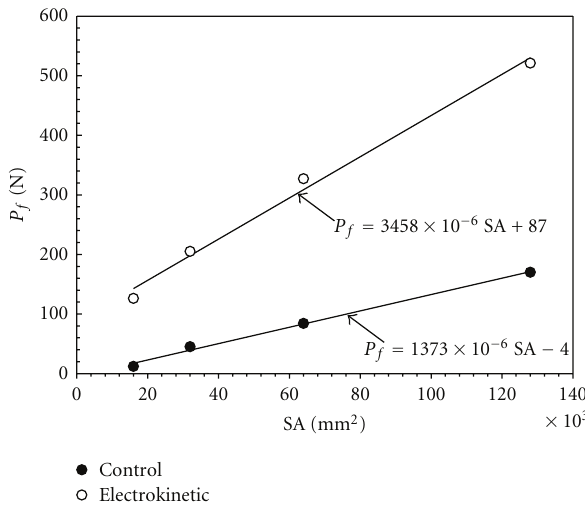
Figure 8: Axial load capacity at failure, P f , versus surface area, SA, of the model